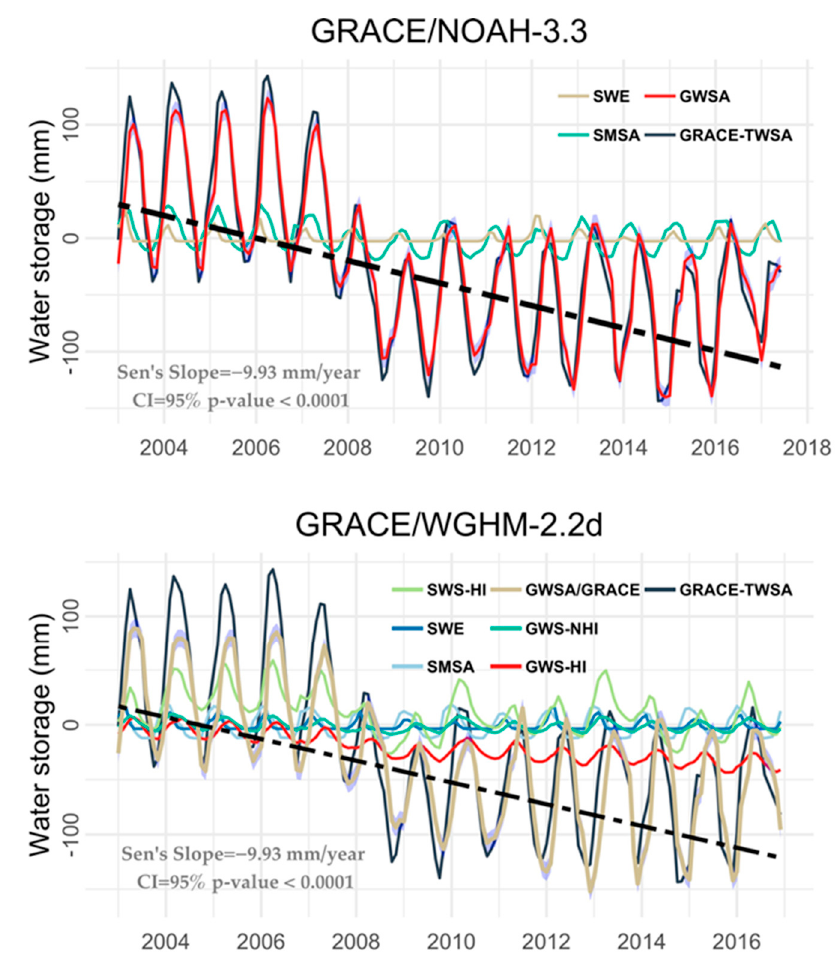
Figure 3. Groundwater storage estimates in the whole Tigris–Euphrates basin (TEB) obtained by applying Equations (1)–(3). In the upper panel, the groundwater storage (GWS) was obtained by removing the soil moisture and snow signals from the NOAH-3.3 model. The GWS is shown in red with its corresponding uncertainty. Similarly, in the lower panel, the GWS was calculated by removing the surface water, snow, and soil moisture signals from the GRACE-TWS. GRACE-GWS is compared with the WGHM-GWS for natural simulations (green line) and natural and human simulations (red lines). The long-term trend (black dashed lines) is the same in the two models—that is, approximately − 9.93 mm / year calculated by the Sen slope at the 95% confidence interval and p -value <